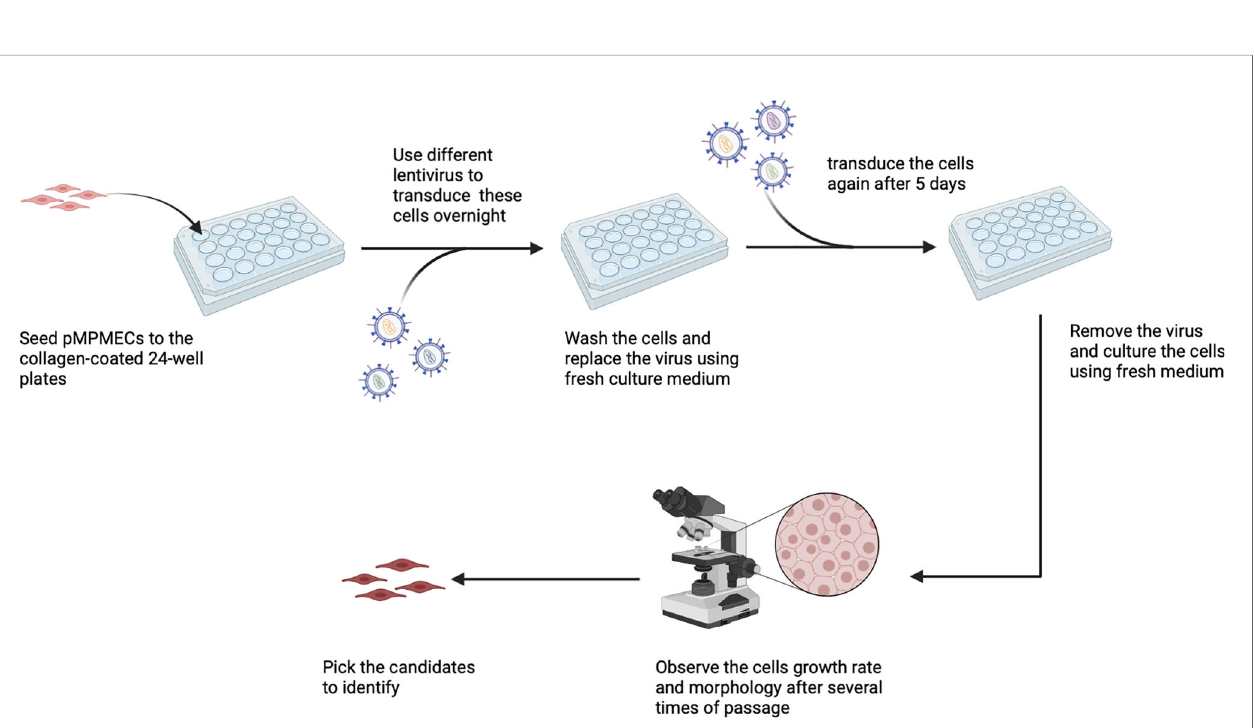
FIGURE 3 | Schematic representation of mouse pulmonary microvascular endothelial cell (MPMEC) immortalization by lentiviruses. Different lentiviruses are used to transduce cells twice and observe the second-transduced MPMEC growth rate and morphology and choose the immortalized candidates. This fi gure is created via Biorender